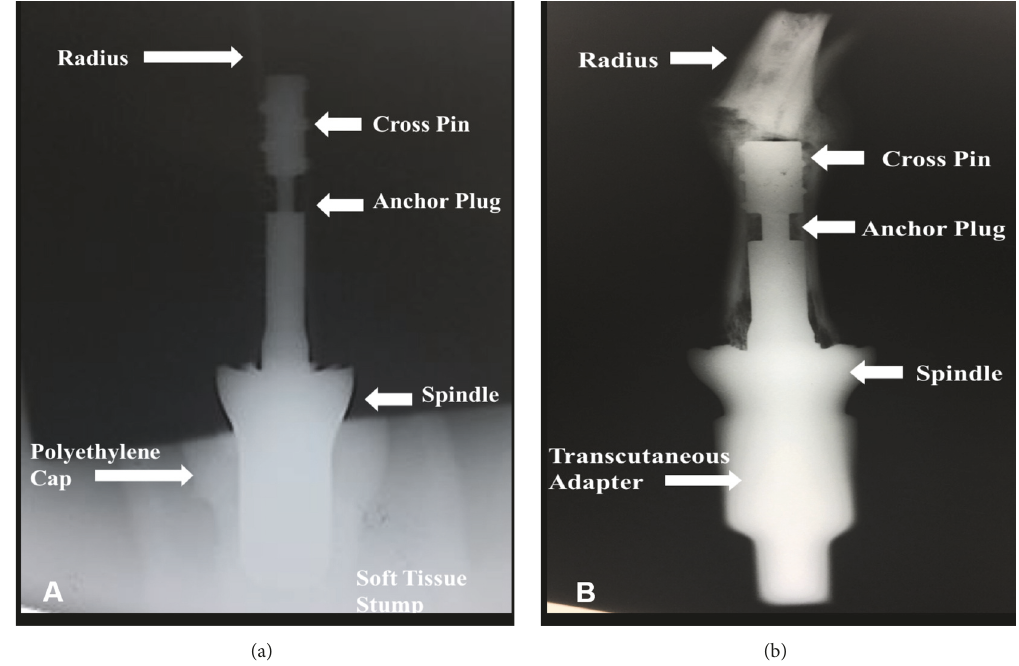
Figure 2: Radiographic images of the staged implant procedure. (a) Implant of spindle components with polyethylene cap and primary wound closure (b) Removal of polyethylene cap which is replaced with a tapered-fit transcutaneous